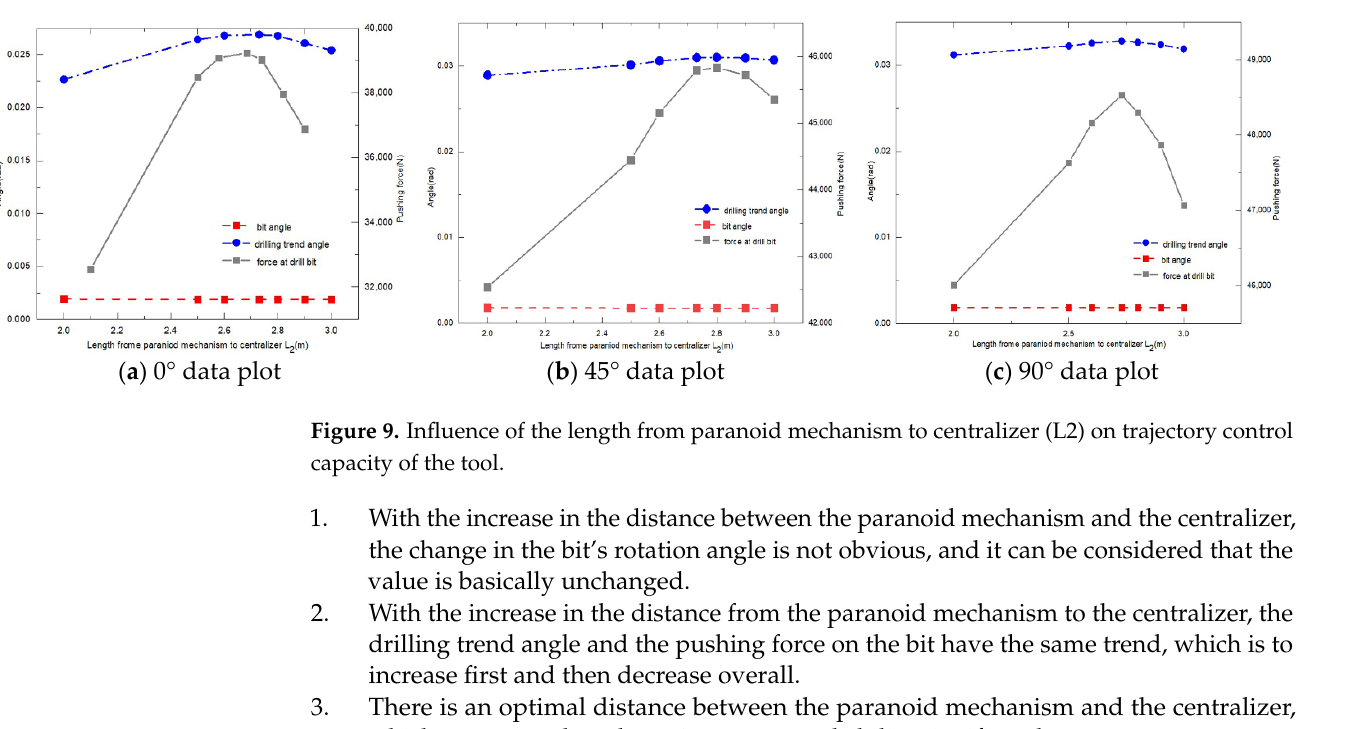
Figure 10. Structure comparison of rotary steerable drilling system.